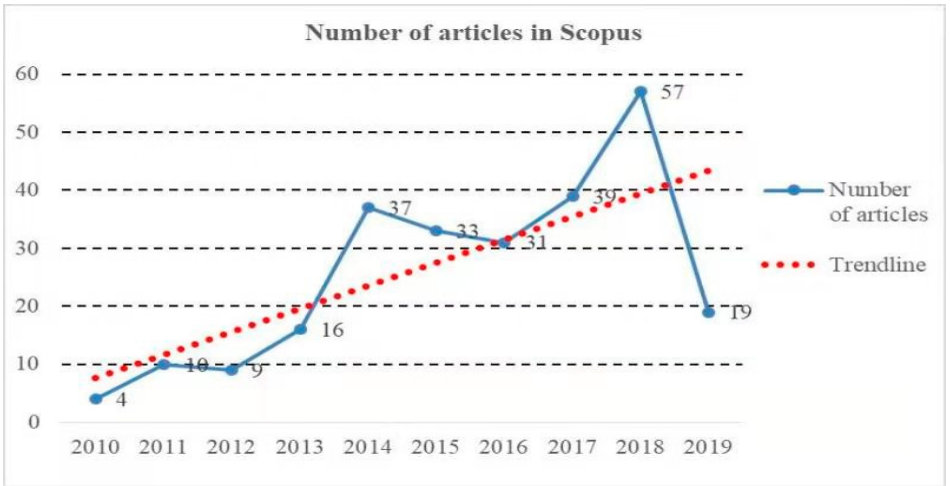
Figure 1. The number of articles in Scopus in 2010–2019.